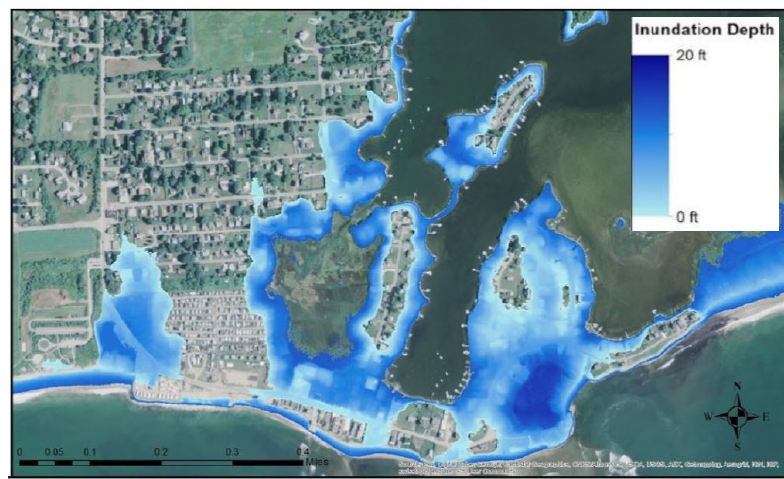
Figure 9. Extent of inundation within the study area from a 100 ‐ year storm event using the online tool STORMTOOLS [9].